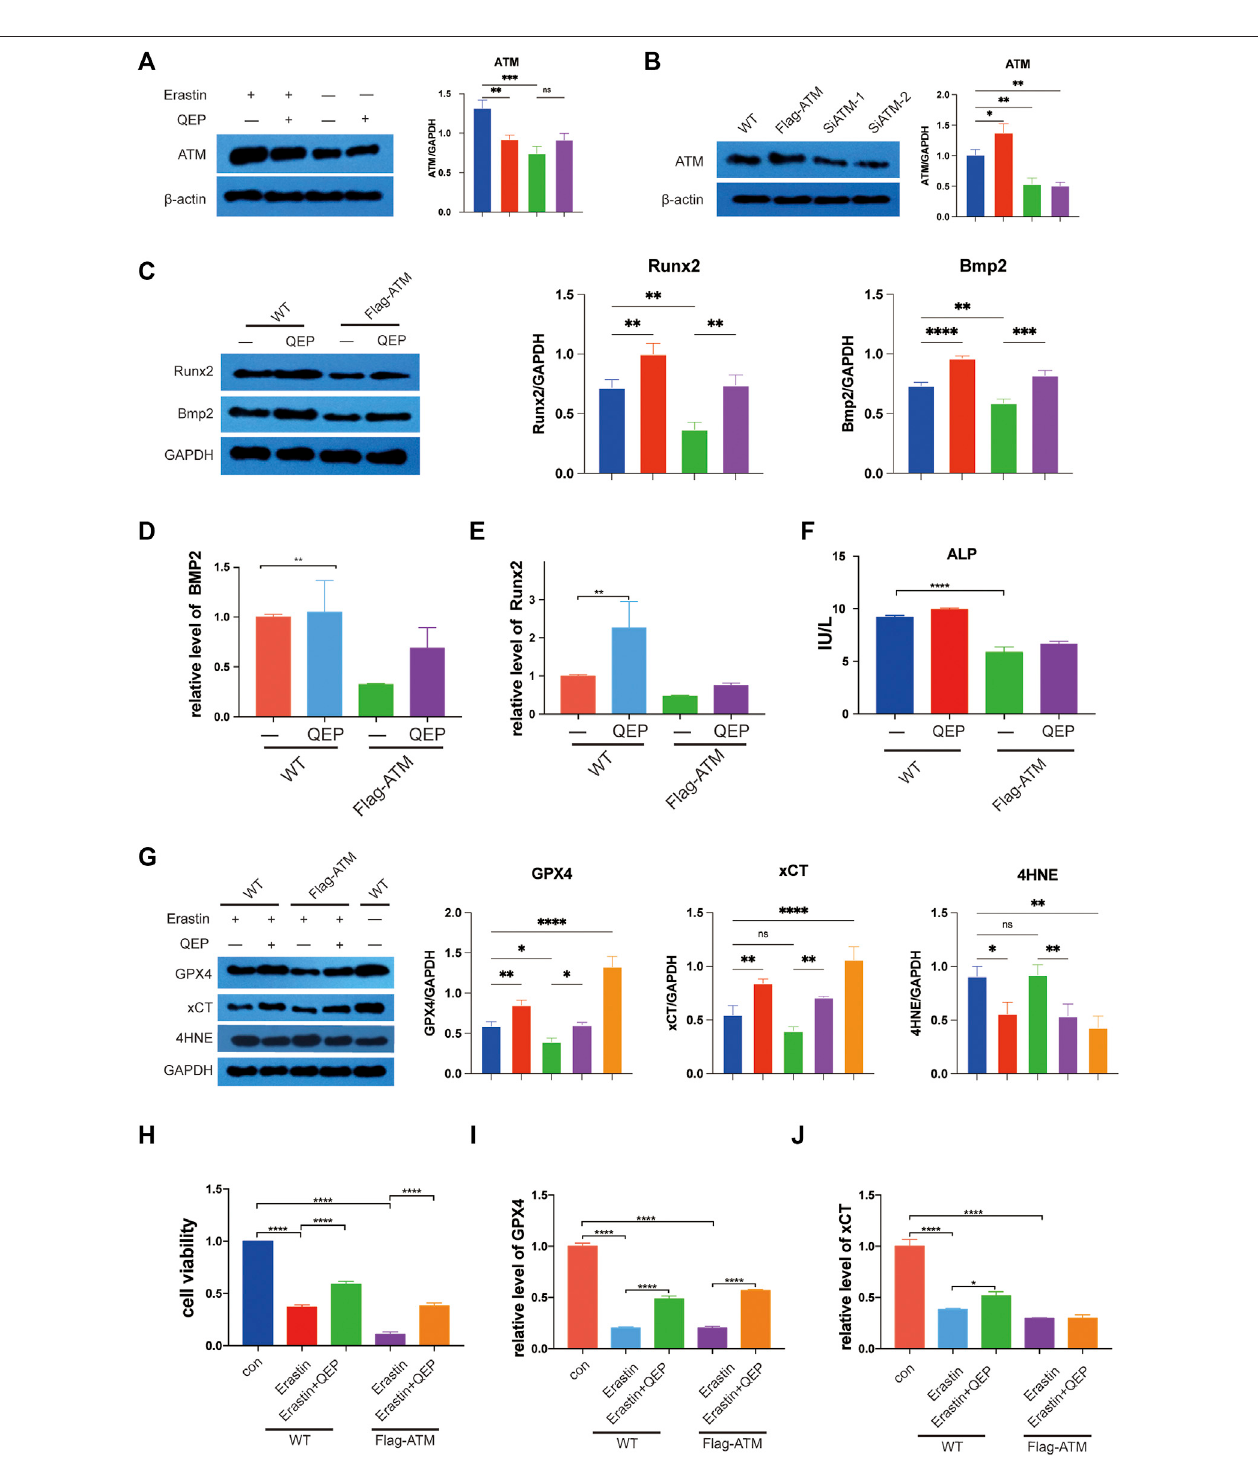
FIGURE4| QEPinhibits theATMexpression and ferroptosis. (A) Western blotshowedthatQEP inhibits ATM. (B) EstablishmentofATMoverexpressingand ATM knockdown hFOB 1.19 cells. (C) QEP enhanced osteogenesis by downregulating ATM. (D – F) Relative mRNA expression of osteogenesis-related genes and ferroptosis-related genes in different groups. (F) Overexpressing ATM decreased ALP in hFOB 1.19 cells. (G) Overexpressing ATM deteriorated ferroptosis induced by erastin,butQEPinhibitedit. (H) QEPimprovedcellviability. (I,J) QEPenhancedthemRNAlevelofferroptosis-relatedgenes(Qing:QEP;* p < 0.05,** p < 0.01,*** p < 0.001, and **** p <